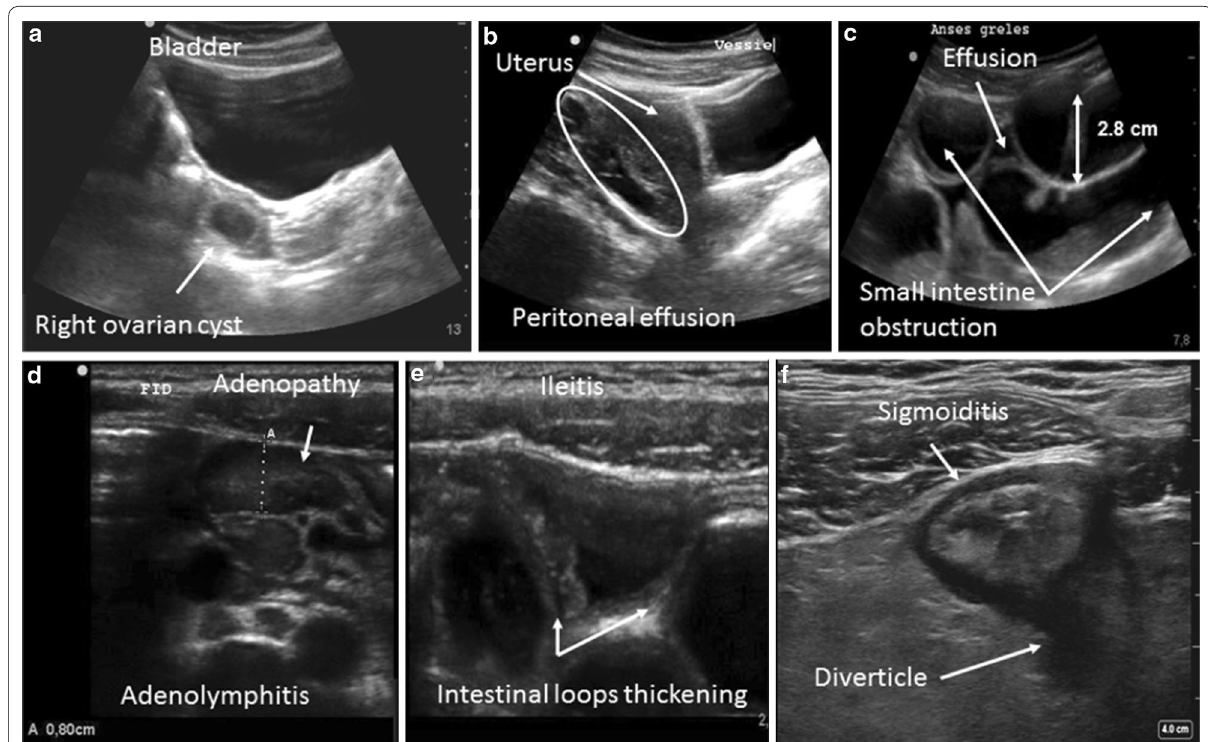
Fig. 1 Examples of abnormal ultrasound images: a a latero‑uterine mass with a sonolucent liquid content suggestive of a complicated ovarian cyst, b isolated peritoneal effusion (often at the bottom of the Douglas pouch), c appearance of a small intestinal occlusion (widening of the intestinal loops by more than 2.5 cm, with a liquid content and possible inter‑loop effusion), d adenopathies (hypoechoic oval images greater than 5 mm in terms of the antero‑posterior diameter, sensitive to passage of the probe, and enhanced by color Doppler), e thickening of the last small intestinal loops suggestive of ileitis (thickening by more than 3 mm of the wall of the digestive tract), f circumferential widening of the colon wall (a pseudo‑kidney appearance) suggestive of an inflammation or an